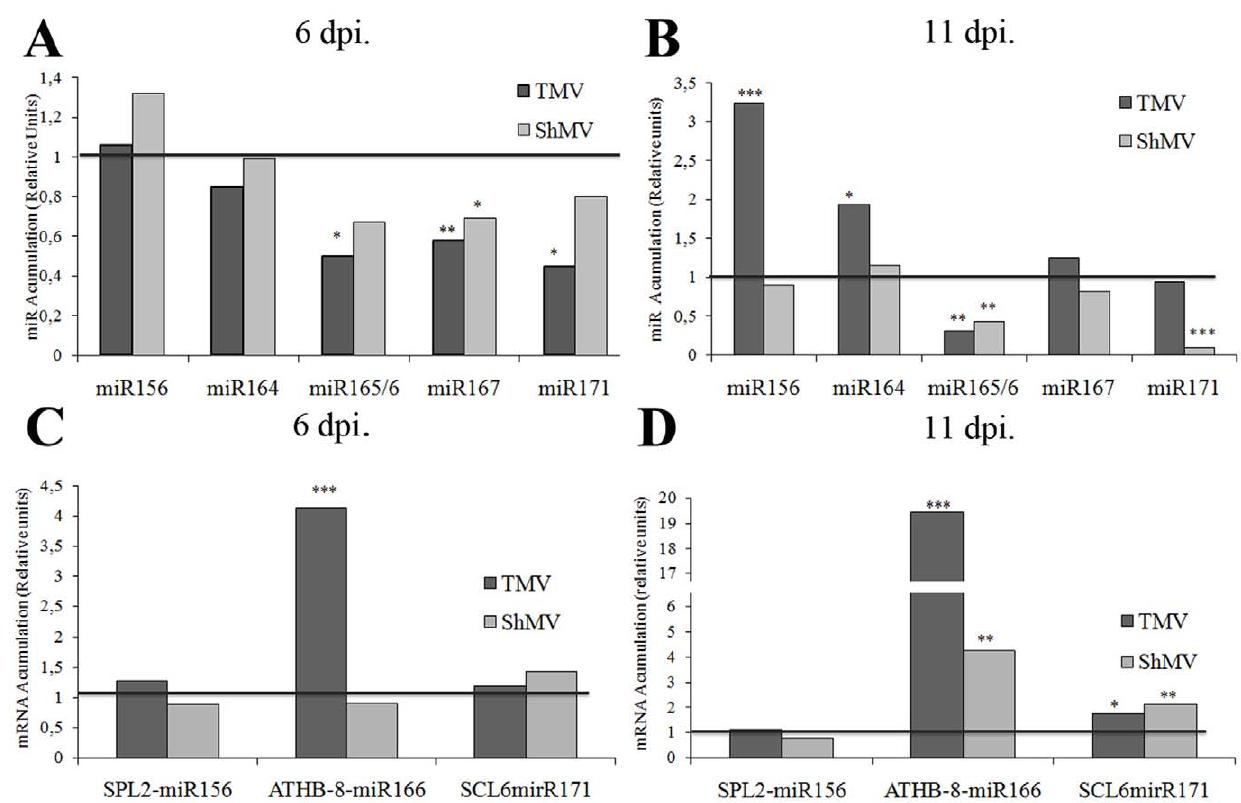
Figure 6. TMV and SHMV infected plants miRNAs and mRNA targets accumulation levels at early time points by qPCR. Relative accumulation of miRNAs 156, 164, 165/6, 167 and 171 ( A,B ), and miRNAs 156, 166, and 171 target genes ( C,D ) on virus-infected plants with low inoculum . A ratio between each virus- and mock-inoculated plants is shown at 6 days post inoculation (dpi) ( A,C ) and 11 dpi ( B,D ). * means p- value , 0.1; ** means p-value , 0.05 and *** means p-value , 0.01.